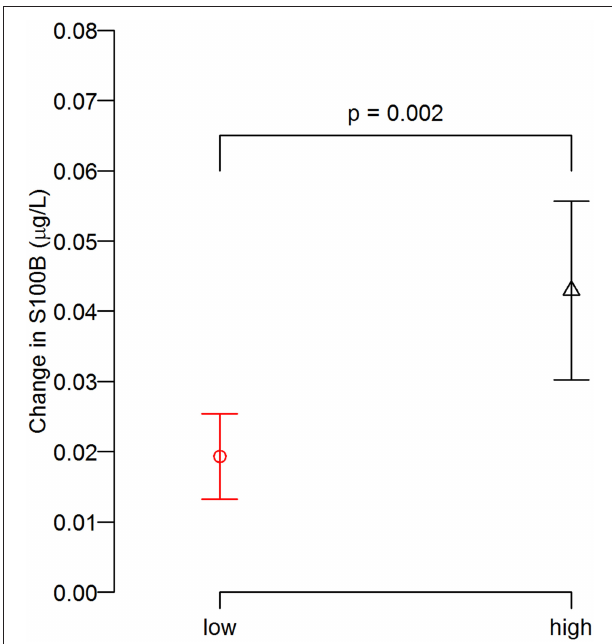
FIGURE 4 | Degree of S100B change (post minus pre) between groups. The post-game S100B increase relative to the pre-game levels in the high impact group was greater than that of low impact